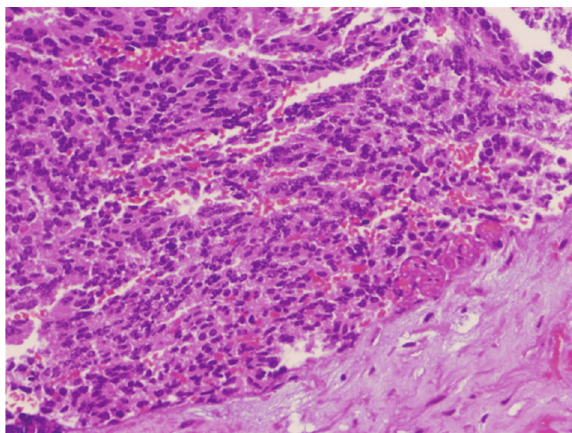
Figure 2: Hematoxylin-eosin (H-E) staining showing groups of glandular cells with di ff erent grades of atypia.